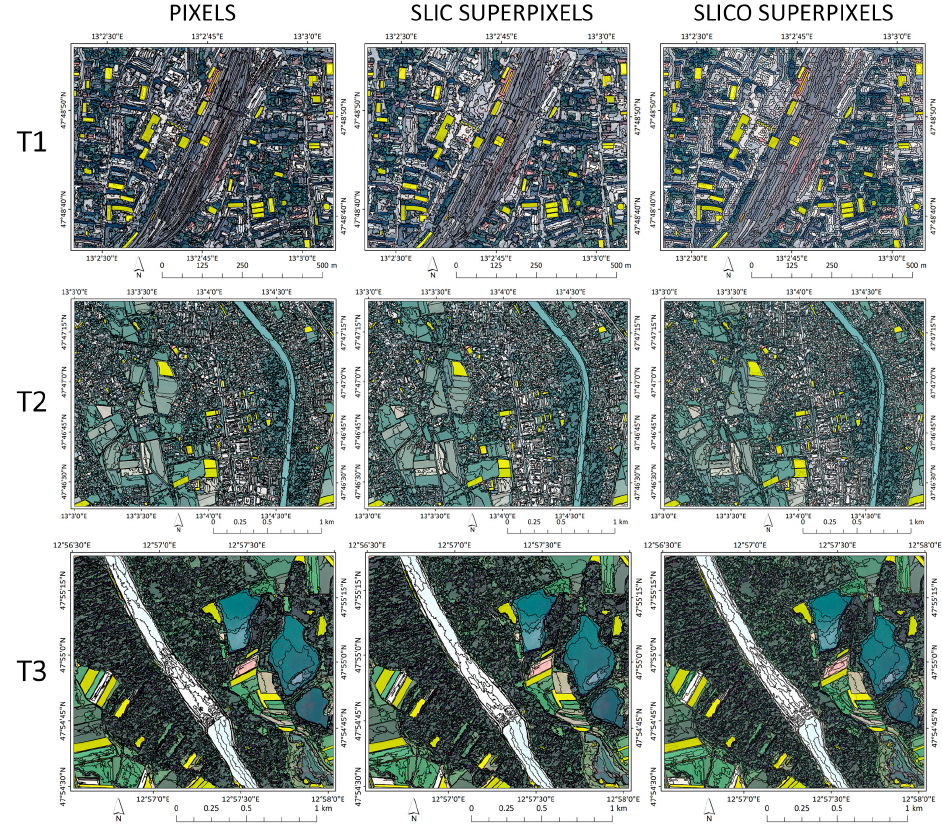
Figure 6. Segmentation results (black outline) and reference polygons (solid yellow) for all test areas (horizontal) and for all three cases of segmentation (vertical).